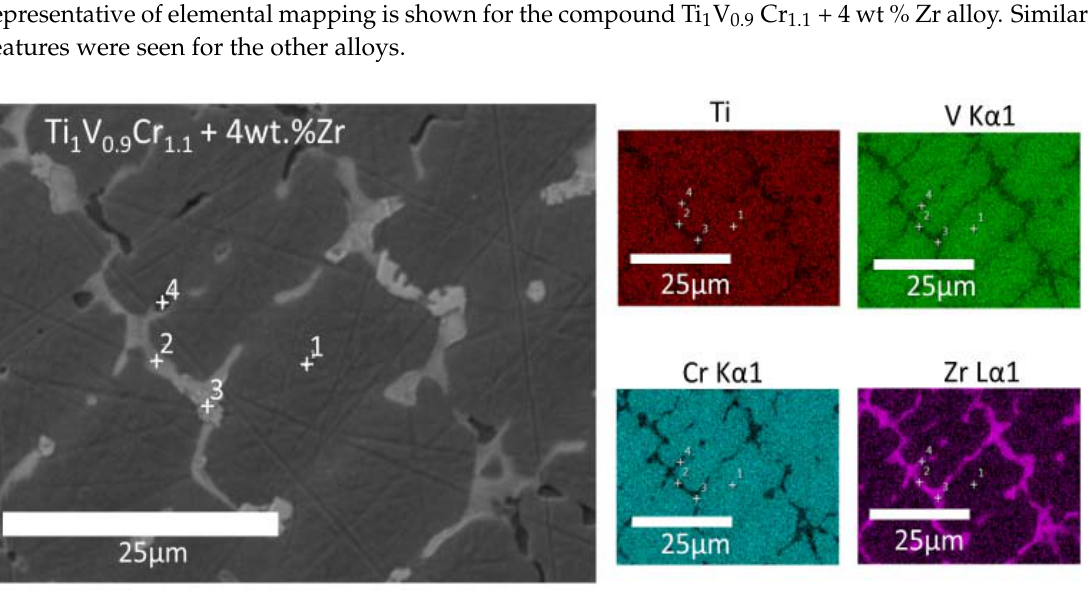
Figure 2. Backscattered electron micrograph of: Ti 1 V 0.9 Cr 1.1 + 4 wt % Zr alloy with elements mapping.